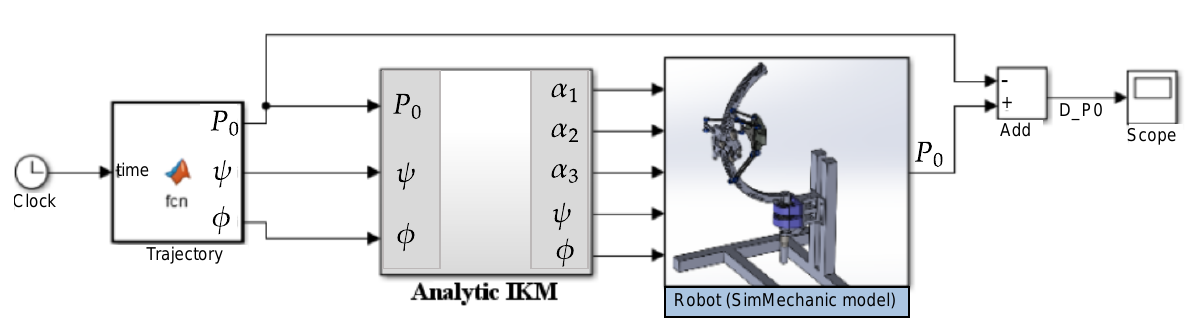
Figure 16. Simulink diagram to validate the IKM implicitly, using FKM.